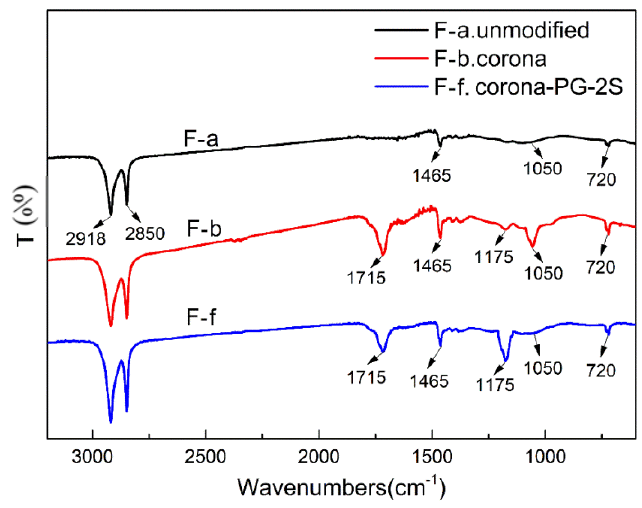
Figure 8. Functional groups of FTIR spectra of the fiber treated by method F-a, F-b and F-f at 0.10 g / mL PVA.